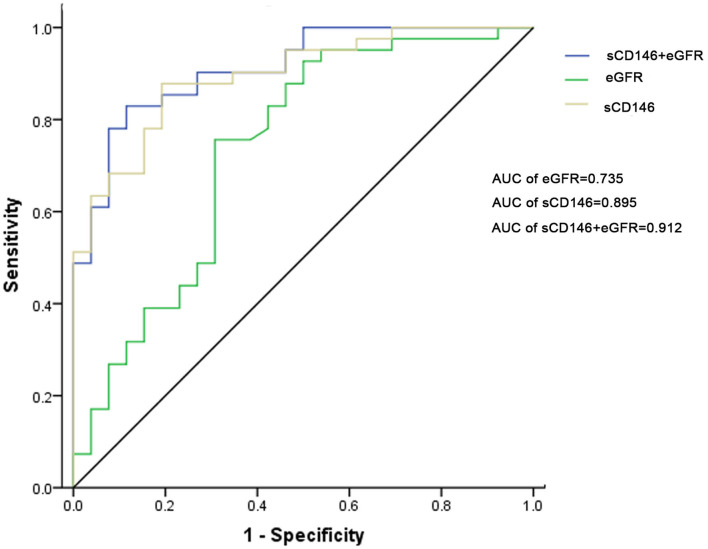
ROC curves for sCD146, eGFR, and the combination model to diagnose acute rejection. The AUC of sCD146 was higher than that of eGFR (P = 0.02496). The AUC of the combination model was not higher than that of sCD146 (P = 0.3697), but higher than that of eGFR (P = 0.003).